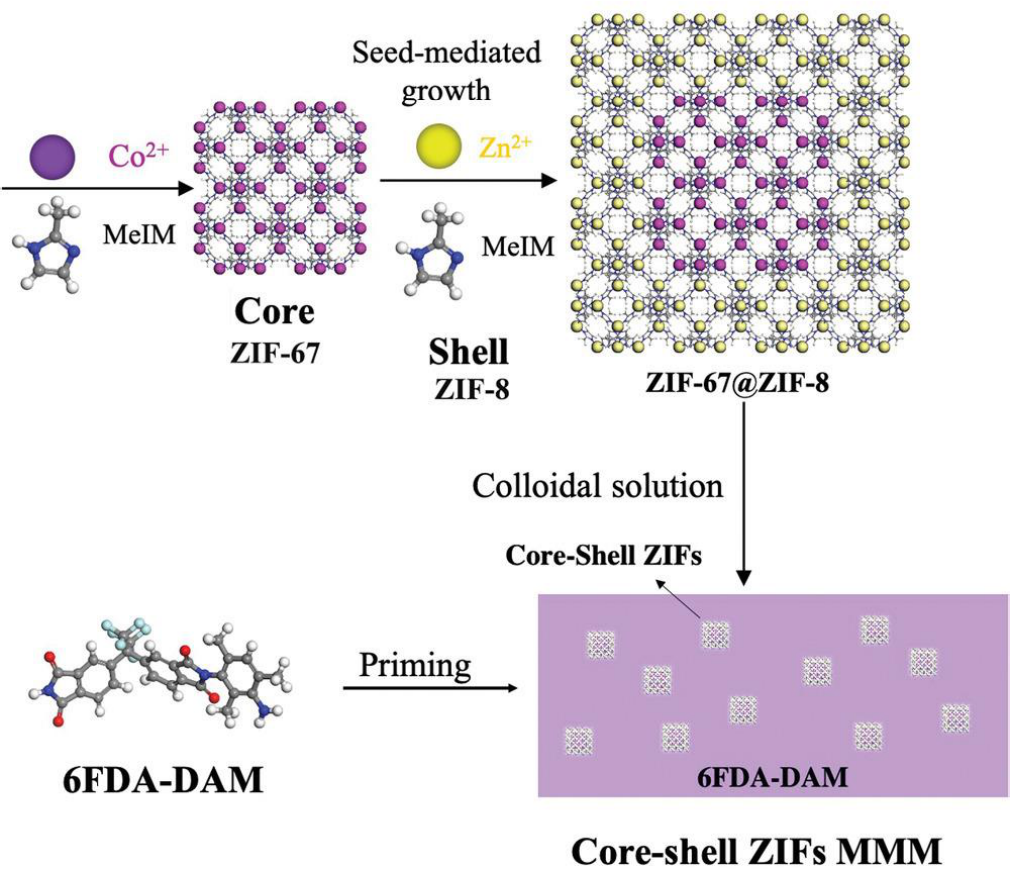
Figure 3. The preparation process of mixed-matrix membranes with core-shell ZIF-67@ZIF-8.